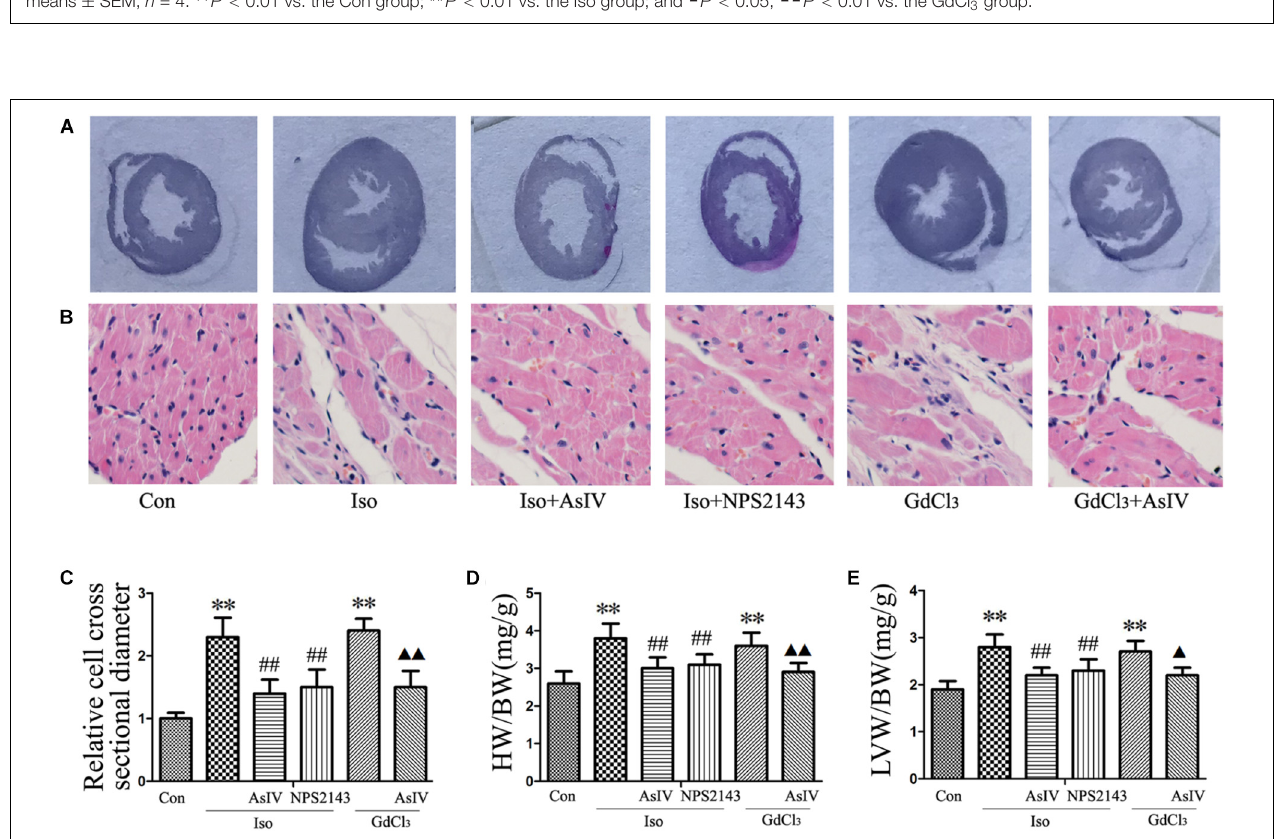
FIGURE 2 | AsIV inhibited cardiac hypertrophy induced by Iso or GdCl 3 in rats . (A) Left ventricular tissue section stained with H&E. (B) Representative example of H&E staining of heart tissue. (C) Statistical data on cell surface area shown by H&E staining and measured and analyzed with LAS Software. (D,E) Ratios of heart weight/body weight (HW/BW) and left ventricular weight/body weight (LVW/BW). Data are expressed as the means ± SEM, n = 4 for A–C; n = 8 for D and E. ∗∗ P < 0.01 vs. the Con group; ## P < 0.01 vs. the Iso group; and (cid:78) P < 0.05, (cid:78)(cid:78) P < 0.01 vs. the GdCl 3 group.